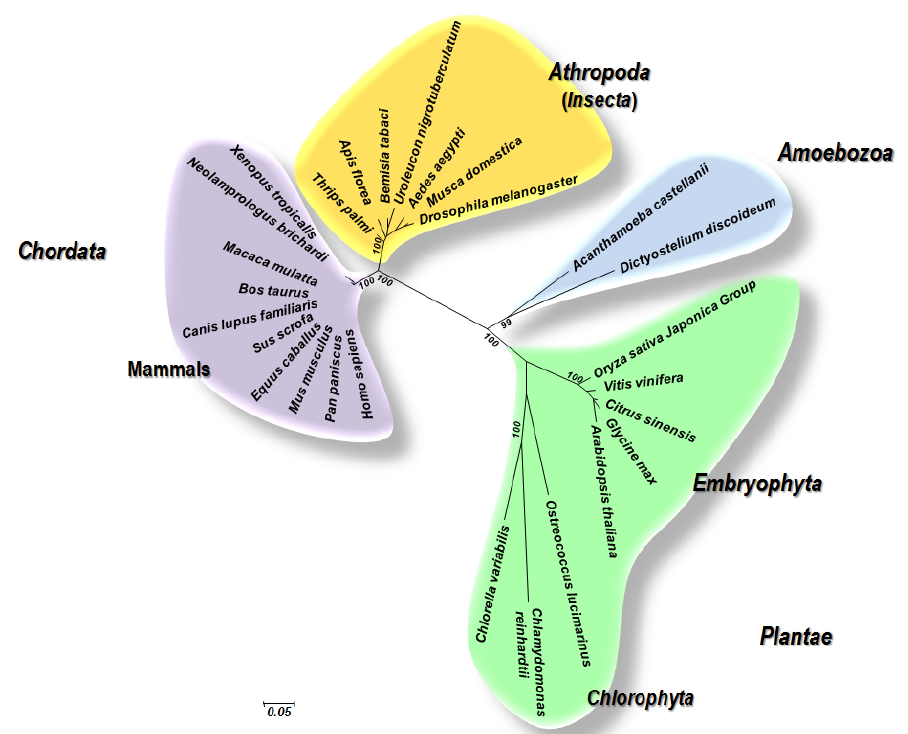
Figure 2. Phylogeny reconstruction based DNA-dependent RNA polymerase subunit 2 for some members of the domain Eukaryota, including land plants, insects and human and other mammals. Phylogenetic analysis was performed using the maximum likelihood method with the MEGA5 software [33], and involved a curated alignment of 27 sequences composed of 1038 amino acid positions. Only bootstrap values at major nodes are shown. Scale bar represents the number of estimated changes per position for a unit of branch